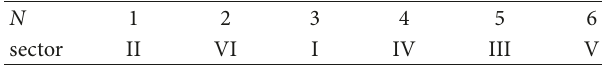
Table 4: The relations between N and the sector where 𝑉 ref is located.